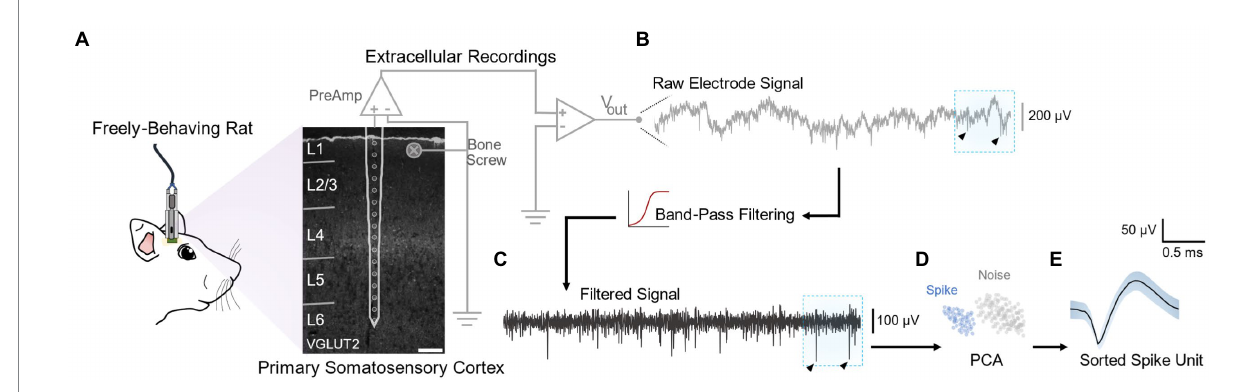
FIGURE 1 Extracellular recordings from freely behaving animals and signal processing pipeline. (A) Extracellular recordings were obtained from planar microelectrode array chronically implanted in the primary somatosensory cortex of freely behaving rats. The 16 channels of the device spanned all cortical layers, as confirmed via coronal histological sections of S1 stained with VGLUT2. The electrode was grounded to a bone-screw and signals were pre-amplified through a digital headstage connected to a NeuroDigitizer biological amplifier. (B) For each recording channel, voltage traces from raw extracellular recordings were obtained at a sampling frequency of ~24 kHz. (C) These raw traces were band-pass filtered (250 Hz − 3 kHz). Arrows on raw and filtered traces indicate exemplar downward deflections characteristic of extracellular spikes. (D) Spike units were sorted from the filtered